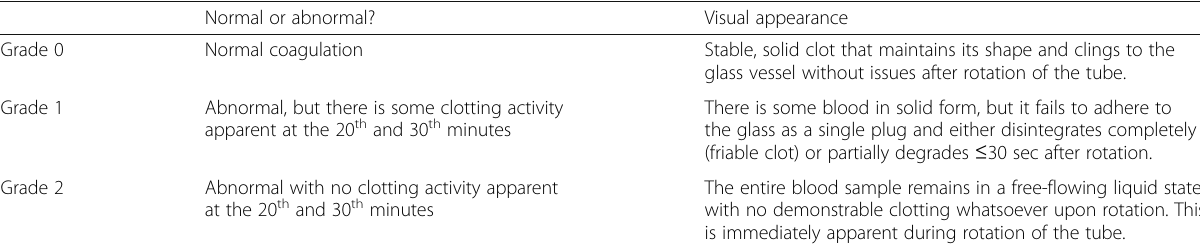
Table 1 Grading system used to score WBCT results at both reading times Normal or